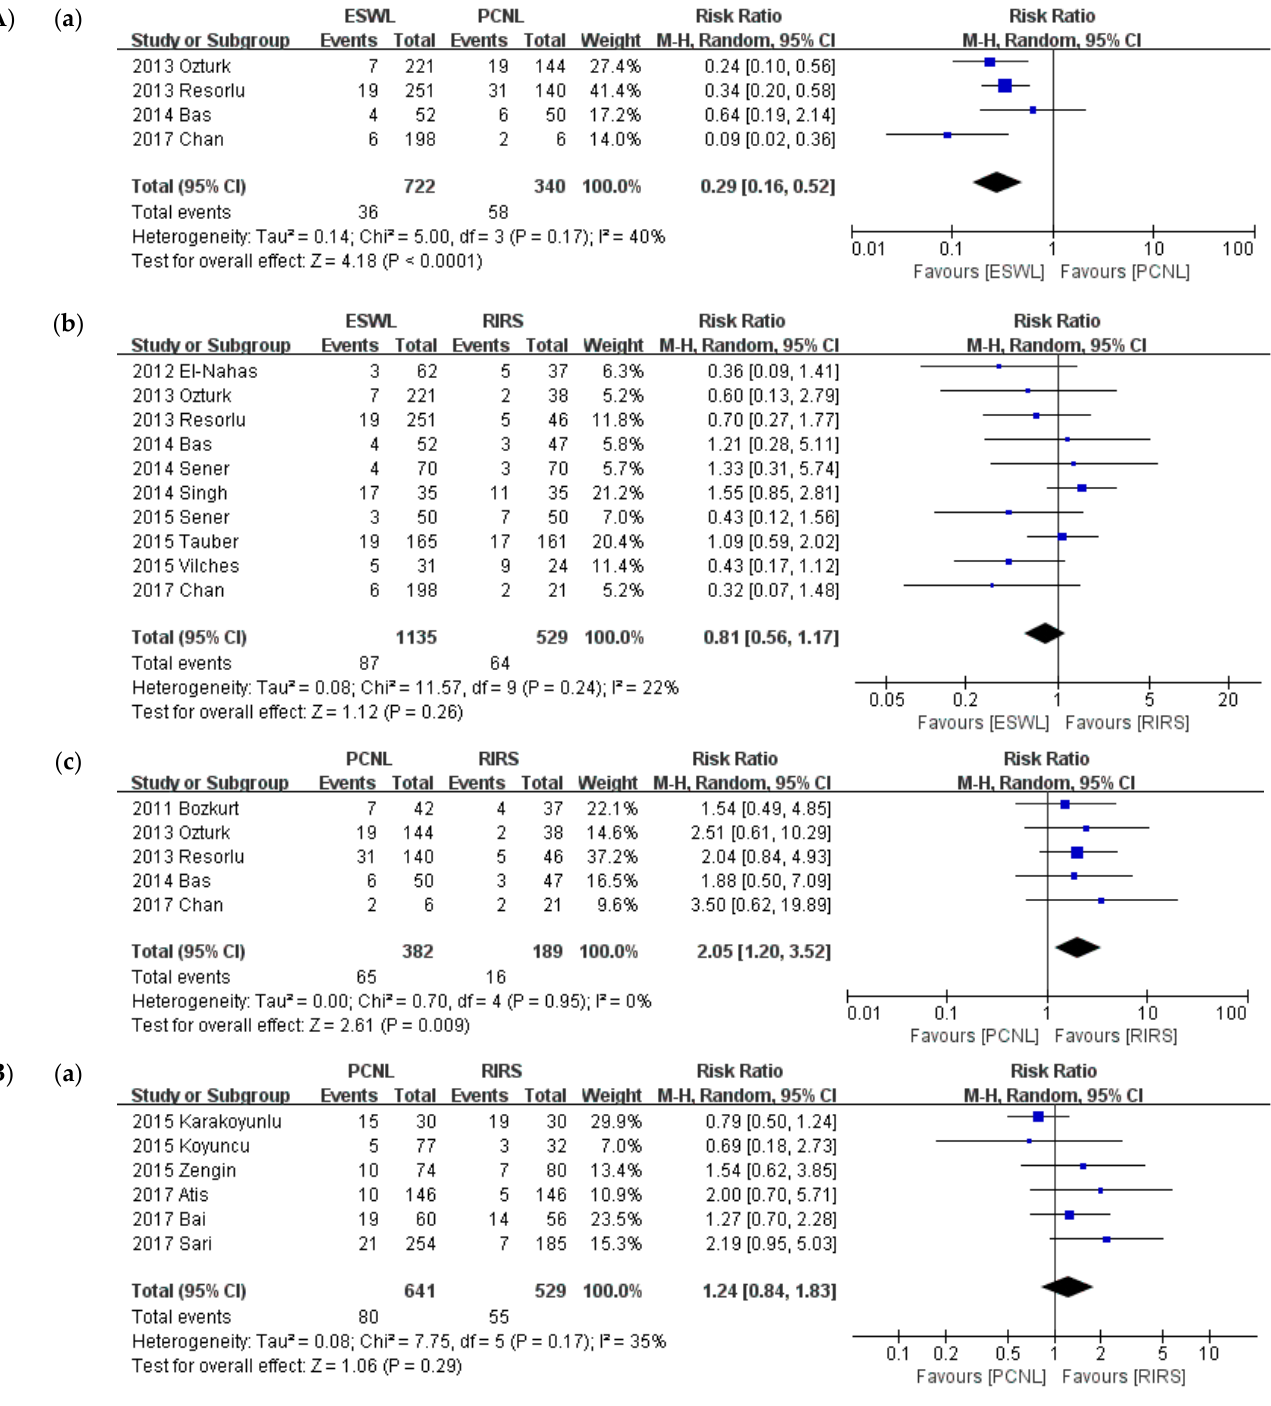
Figure 6. Meta-analysis ( A ). Total complications (stone size ≤ 2 cm): ( a ) ESWL vs. PCNL; ( b ) ESWL vs. RIRS; and ( c ) PCNL vs. RIRS. Meta-analysis ( B ). Total complications (stone size > 2 cm): ( a ) PCNL vs. RIRS.